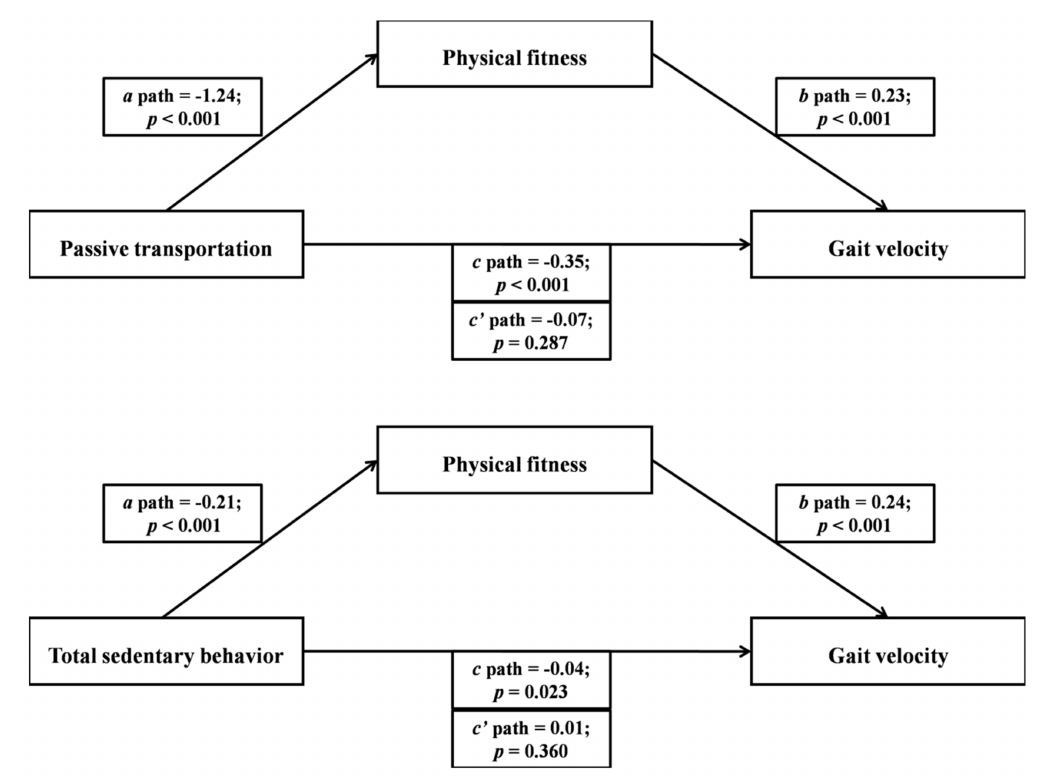
Figure 2. The mediating role of physical fitness in the association between passive transportation and total sedentary behavior with gait velocity ( N =